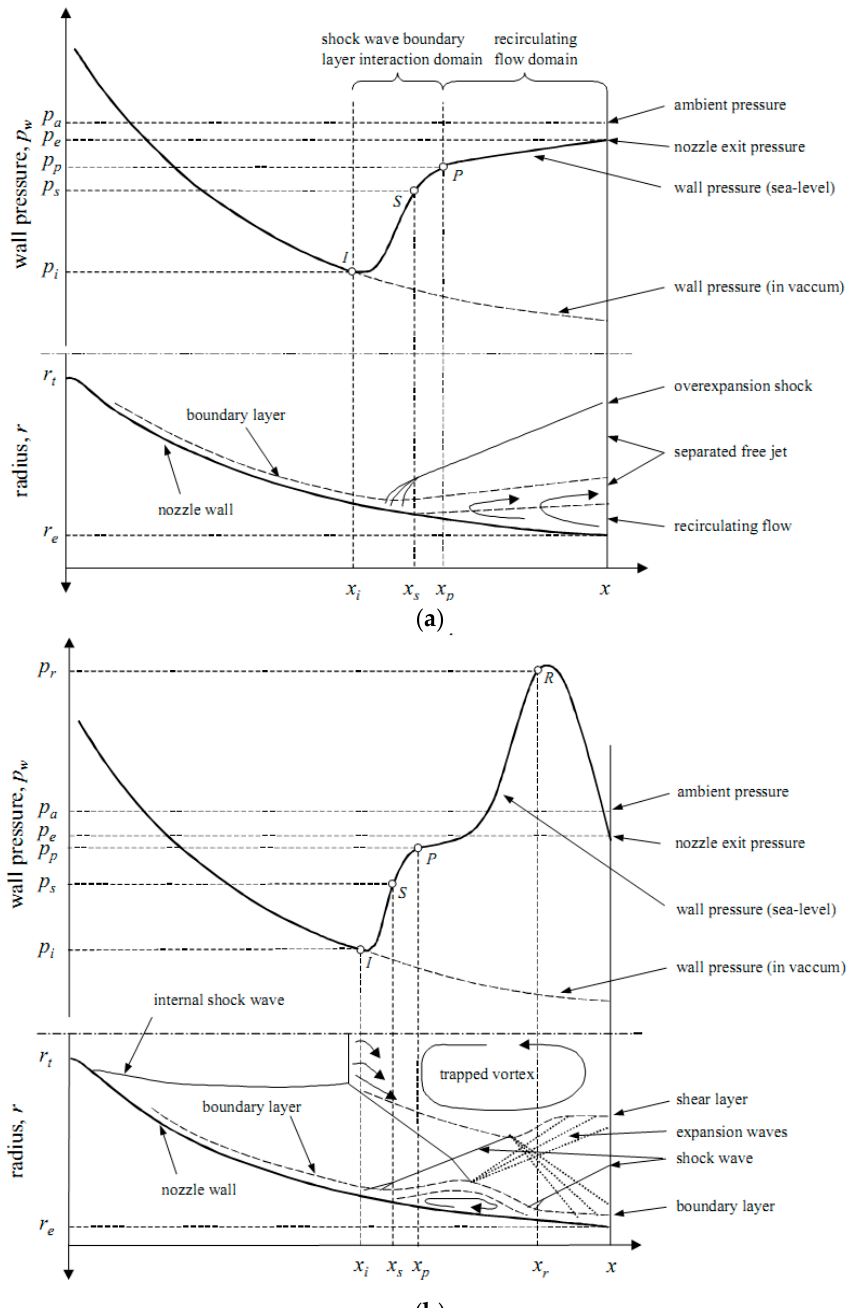
Figure 1. Two aerodynamic separation modes in nozzle. ( a ) Free shock separation. ( b ) Confined shock separation.